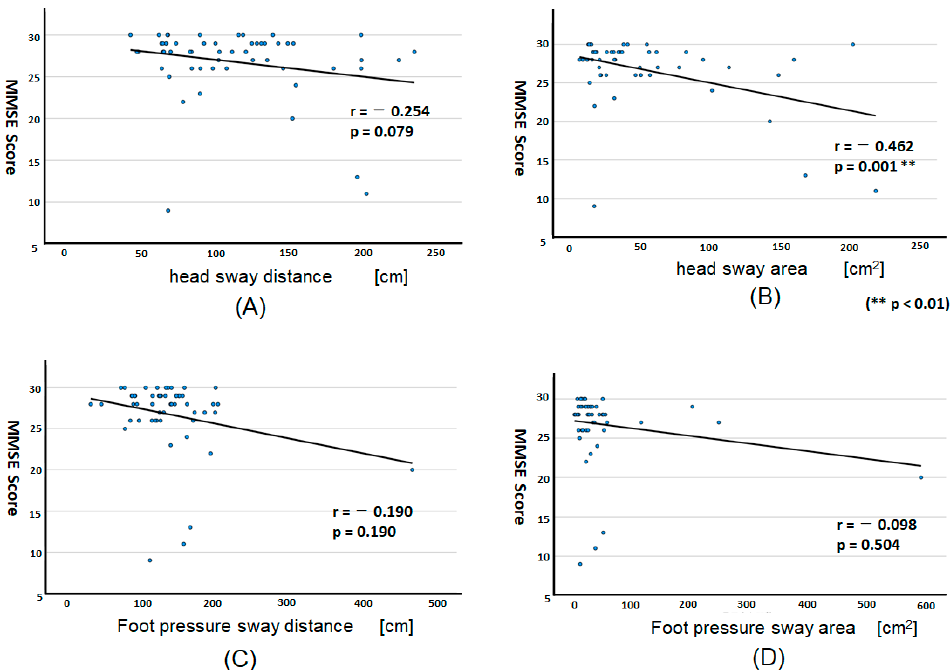
Figure 2. Correlation plotting between MMSE score and sway test results standing on one leg. Sway tests were performed when individuals were standing on one leg with EO ( n = 54). The correlation was plotted for the head sway distance ( A ) and area ( B ), the foot pressure sway distance ( C ), and area ( D ). ** p <0.01. Table 2. Relationship between MMSE subscale and the sway test result in one-leg sway test